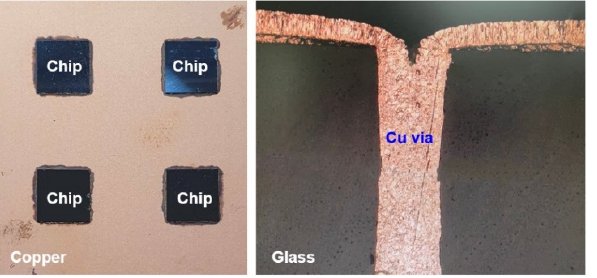
Figure 1. Illustration of mounted chip on TGV interposer and cross-sectional view of Cu-filled glass via.